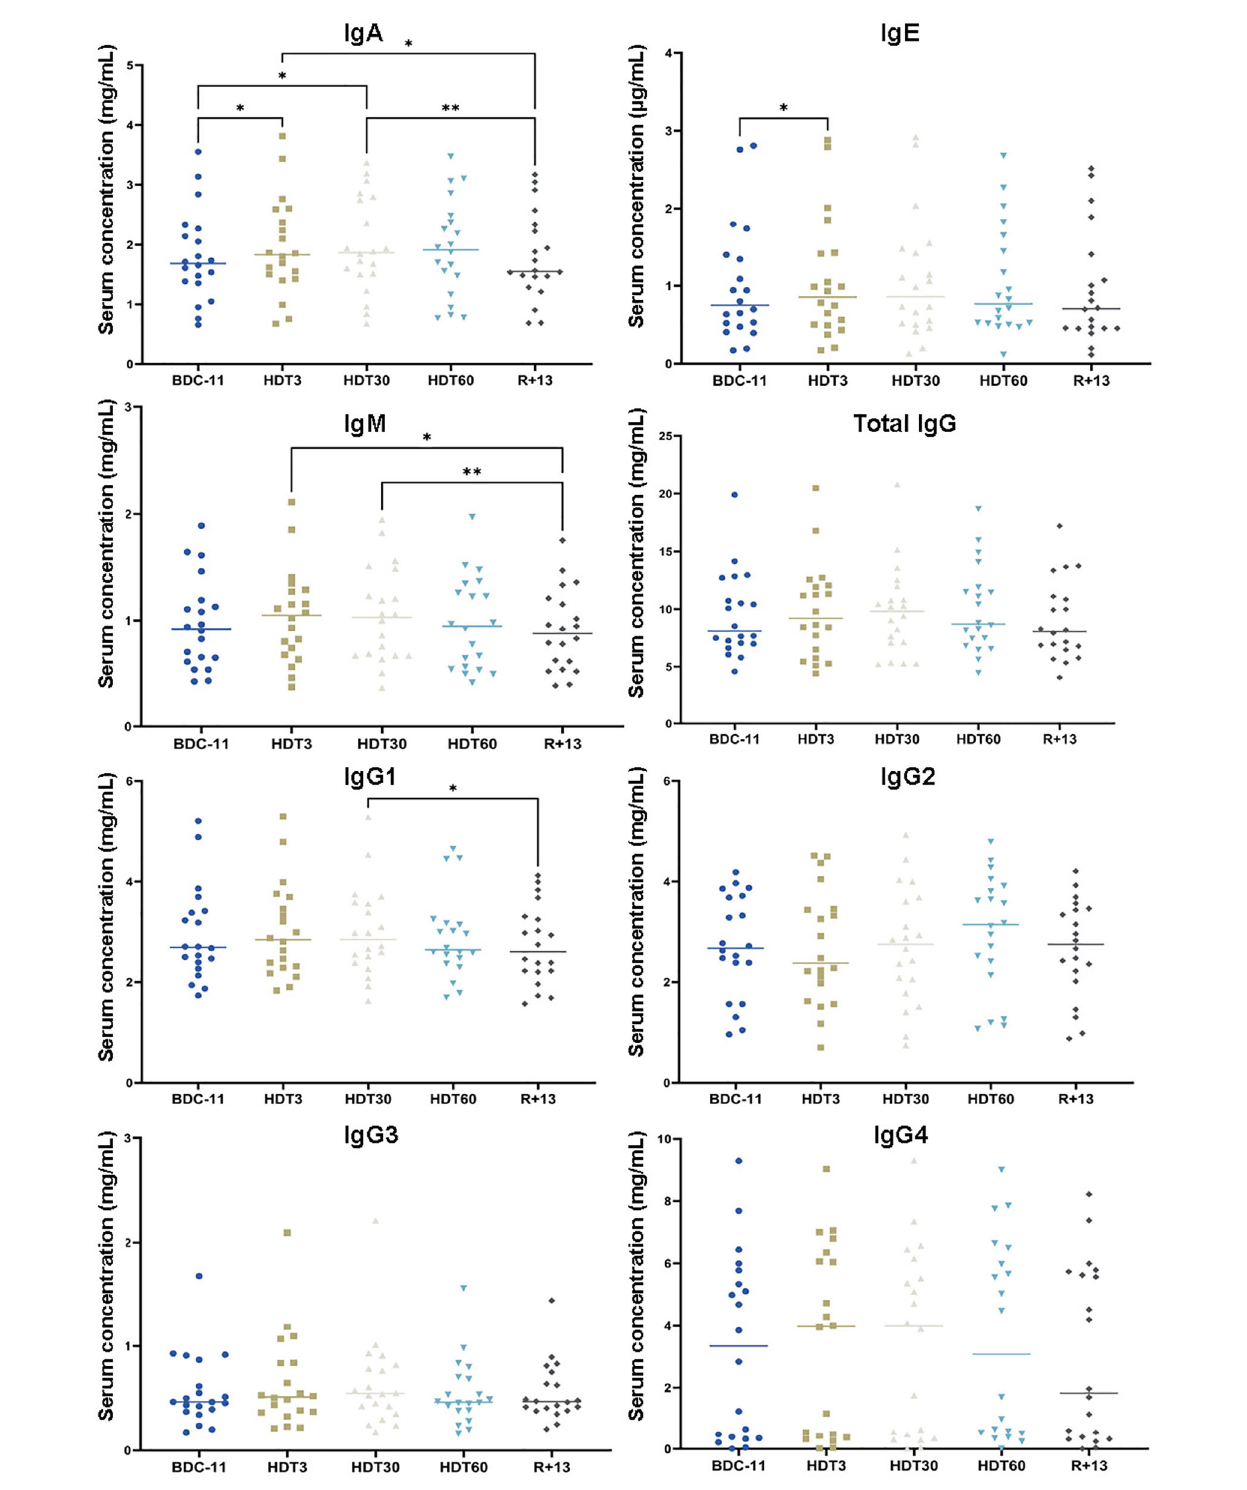
FIGURE 4 | Changes in serum isotype concentrations. As no statistically signi fi cant differences between the control and cocktail groups were observed, individuals of both groups were pooled. n = 20. Horizontal bars indicate the median. Statistically signi fi cant differences were found using either one-way ANOVA or a linear mixed effects model analysis. *p < 0.05; **p < 0.01. BDC, baseline data collection; HDT, head-down tilt bed rest; R, recovery.